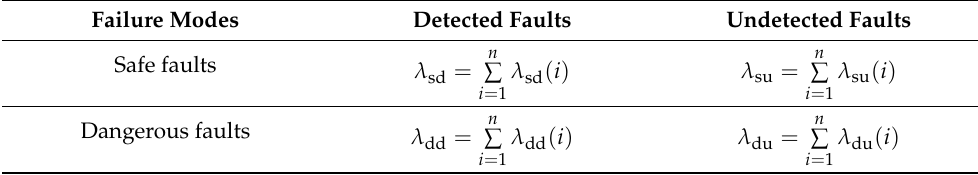
Table 1. Failure rates for different failure modes.